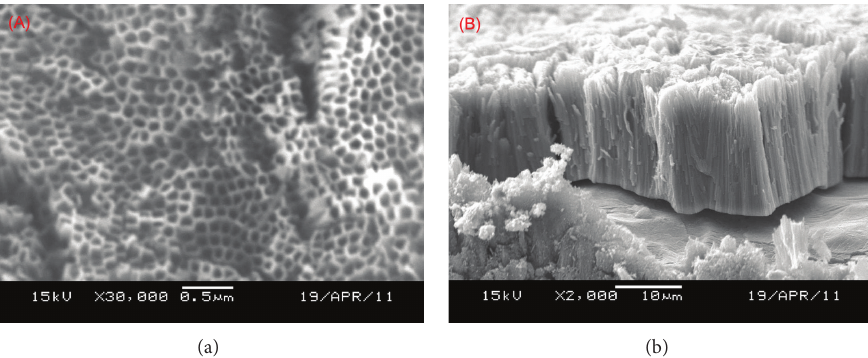
Figure 7: Morphologies of the TiO 2 nanotube arrays grown on polishing-chemical etching Ti plate (a) top view and (b) side view.